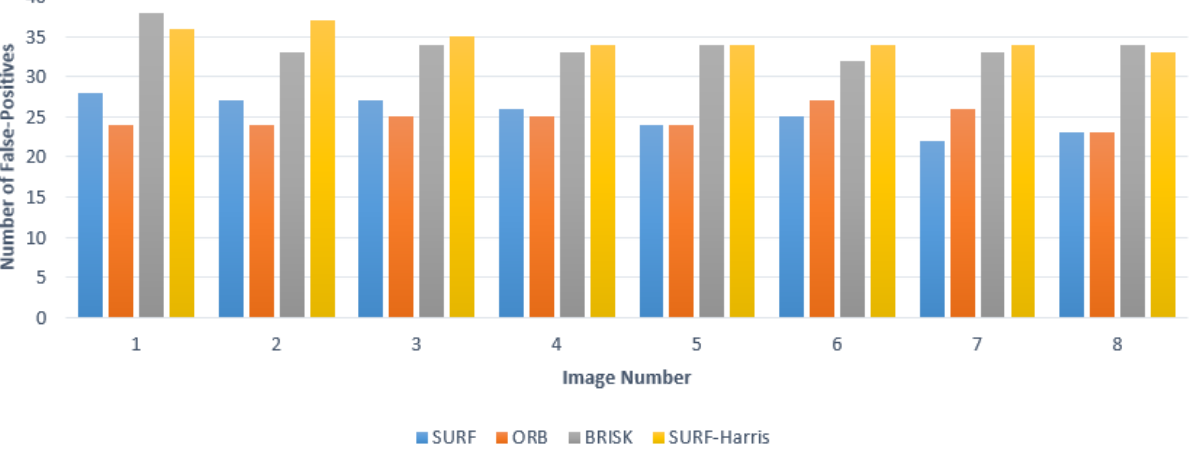
Figure 19. Number of false-positives detected amongst the 50 best interest points detected in each image of dataset 1.